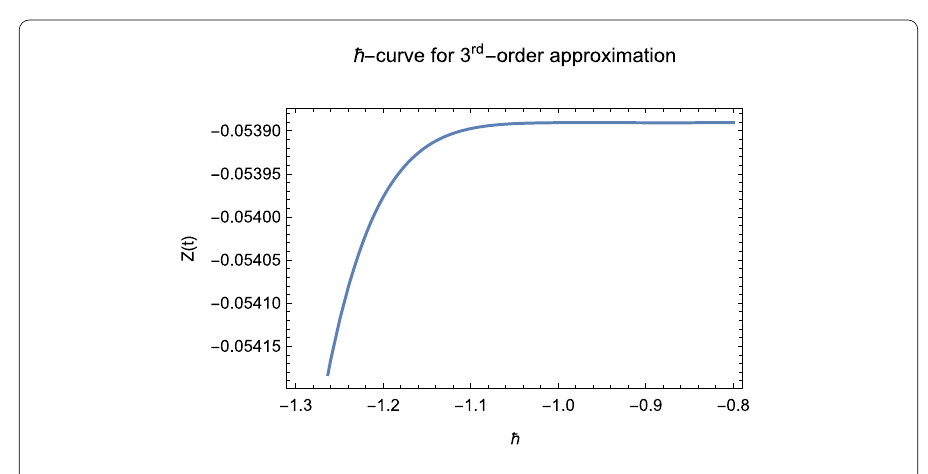
Figure 5 The h -curves of the third-order approximations for Z ( t